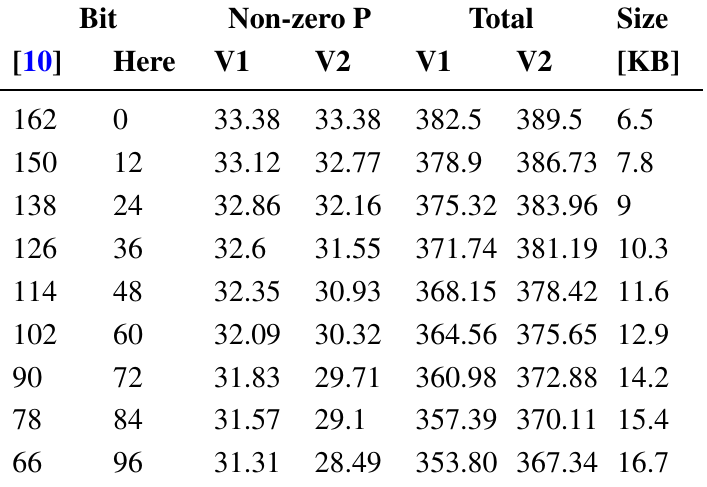
Table 4. Performance evaluation for hybrid model in the case of 3NAF; versions 1 (V1) and 2 (V2) have the same table size. The bit section indicates the ratio of bits using our method and that of [10], respectively. Non-zero P: non-zero